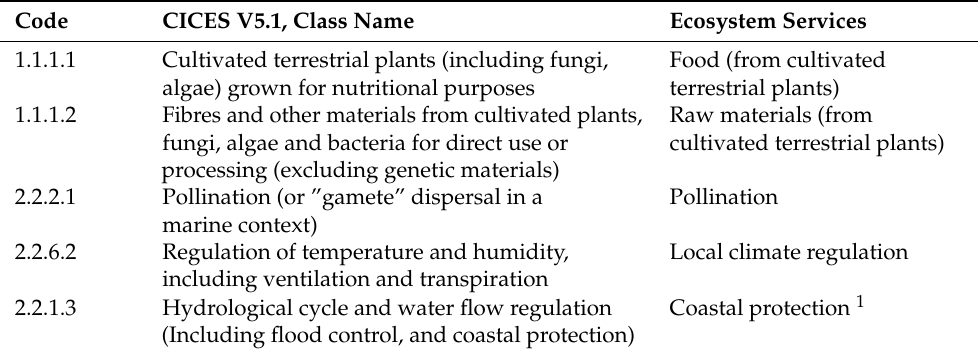
Table 1. Classification of selected ES after CICES V5.1